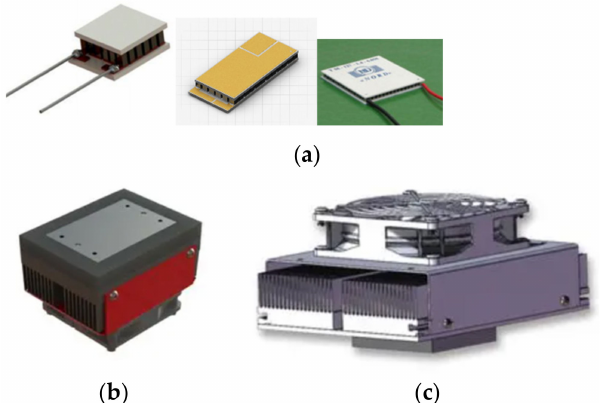
Figure 3. Examples: ( a ) multi-cell Peltier heat pumps [33]; ( b ) Peltier heat pump with cooling fin [34]; ( c ) Peltier heat pump with cooling fin and fan [35].